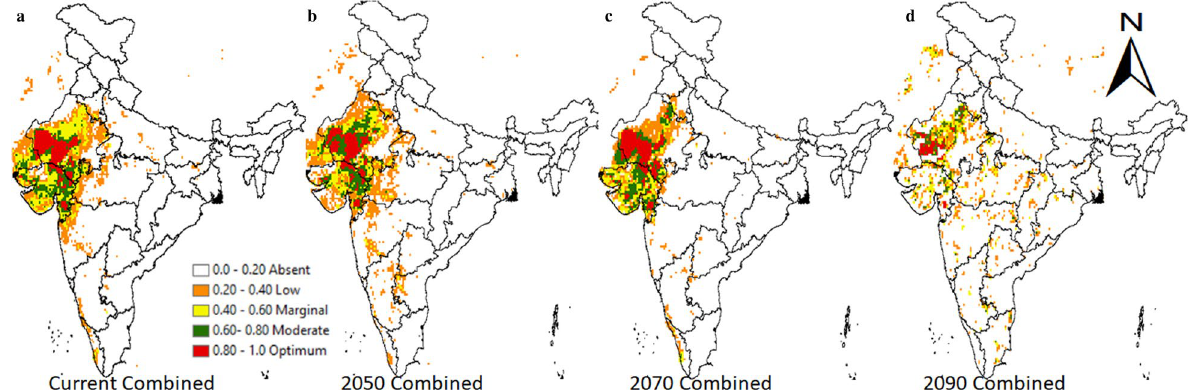
Fig. 17 Projected habitat suitability classes of C. wightii in India with combinations of bioclimatic and non-bioclimatic variables (habitat heterogeneity indices land use slope soil), current combination ( a ), 2050 combination ( b ), 2070 combination ( c ) and 2090 combination ( d + + +